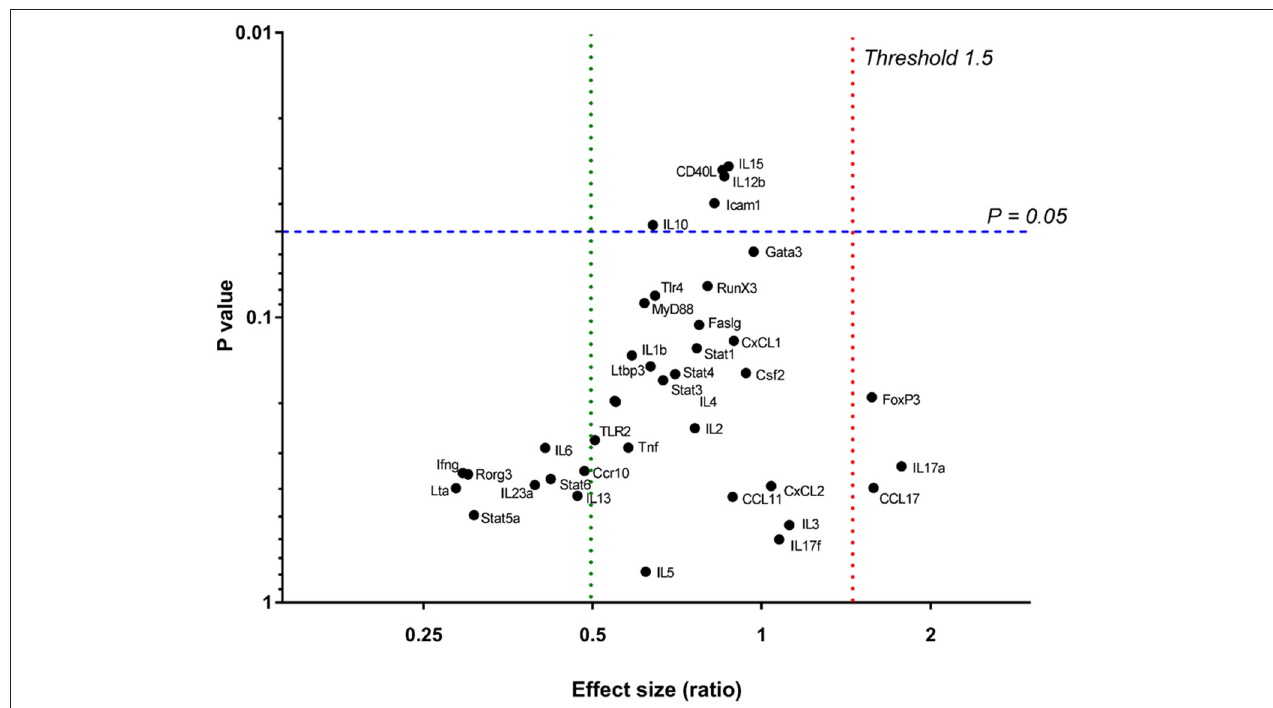
FIGURE 4 | Relative gene expression in spleens of 15 infected vs. nine control rats. P = 0.05 is signified by a blue dashed line. The upper expression threshold (upregulated genes) (Effect size [ratio]) of 1.5 is signified by a red dotted line and lower expression (downregulated) threshold of 0.5, by a green dotted